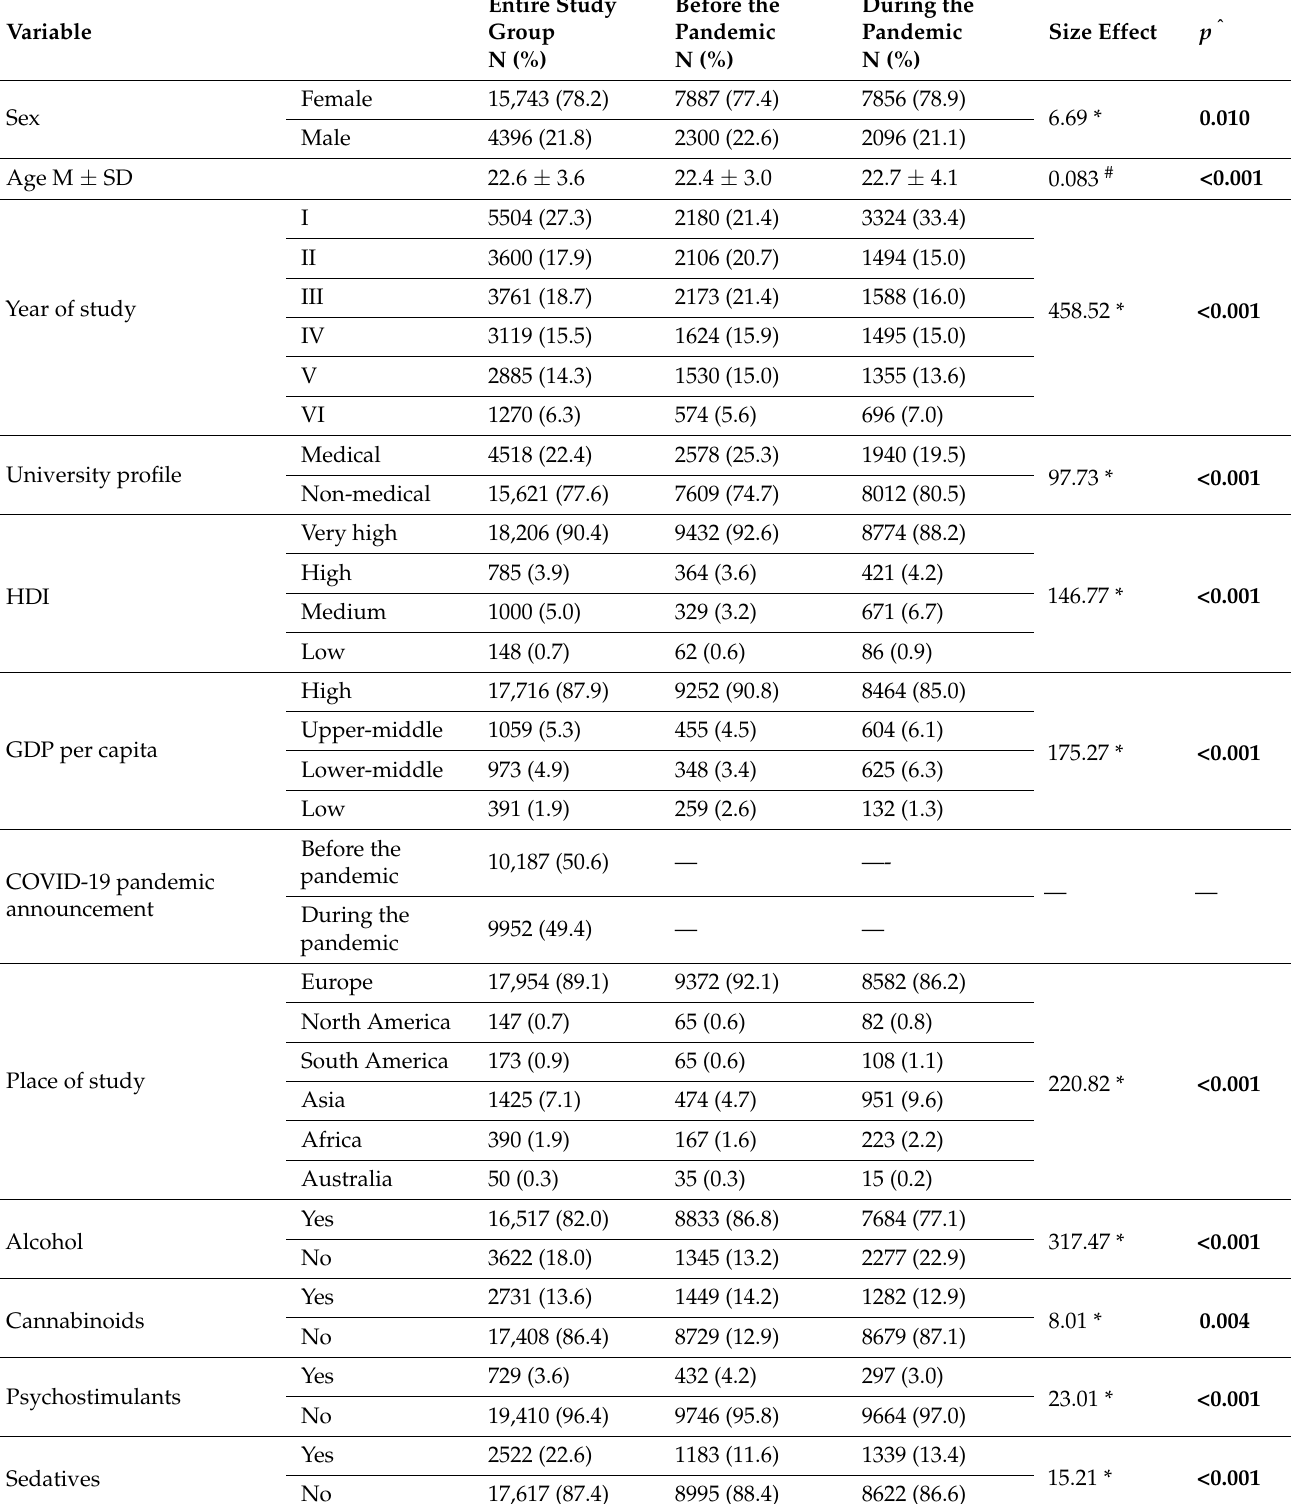
Table 1. Characteristics of the study group for the total population and by the COVID-19